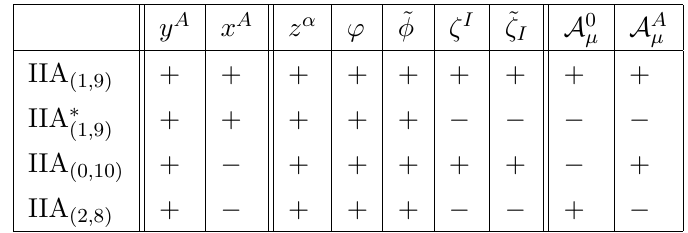
Table 10 . Signs of the kinetic terms for scalar and vector fields resulting from type-IIA CY3 compactifications. A + indicates a standard kinetic term. The fields y A , x A are the vector multiplet